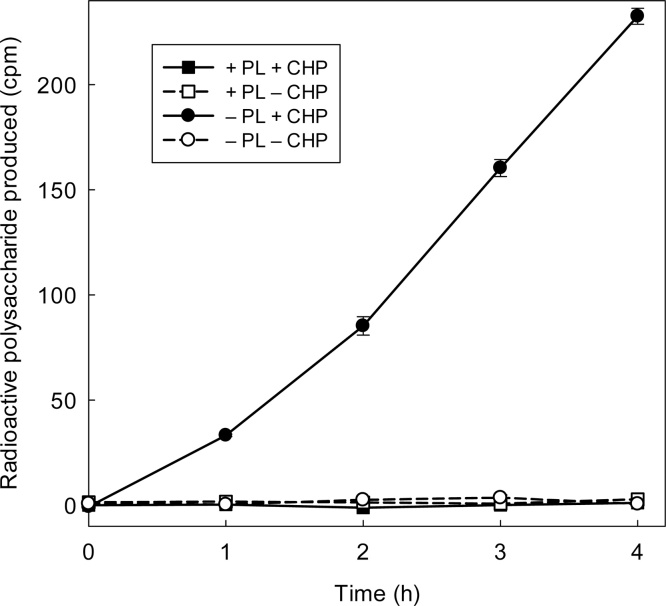
Polylysine blocks the XTH24 binding sites of glass and abolishes the CHP effect. Surface sites on borosilicate glass tubes were blocked by steeping overnight at 20 °C with polylysine (+PL; 0.5 ml, 0.05% w/v in 0.5% w/v chlorobutanol); control tubes (–PL) received 0.5 ml H2O. All tubes were then rinsed with 30 ml water, removing unbound PL. Dilute XTH24 (75 μl; protein concentration 2.16 μg/ml) was then incubated in each tube for 2 h, giving the enzyme the opportunity to bind to the glass, then the tubes were again rinsed with water, removing unbound enzyme. Finally, each tube received 150 μl XET assay mixture, with or without 1.5 mg/ml, and at intervals 20 μl was removed and assayed for [3H]polysaccharide. A yield of 100 cpm of 3H-polysaccharide indicates 3.7 pmol XXXGol incorporated.